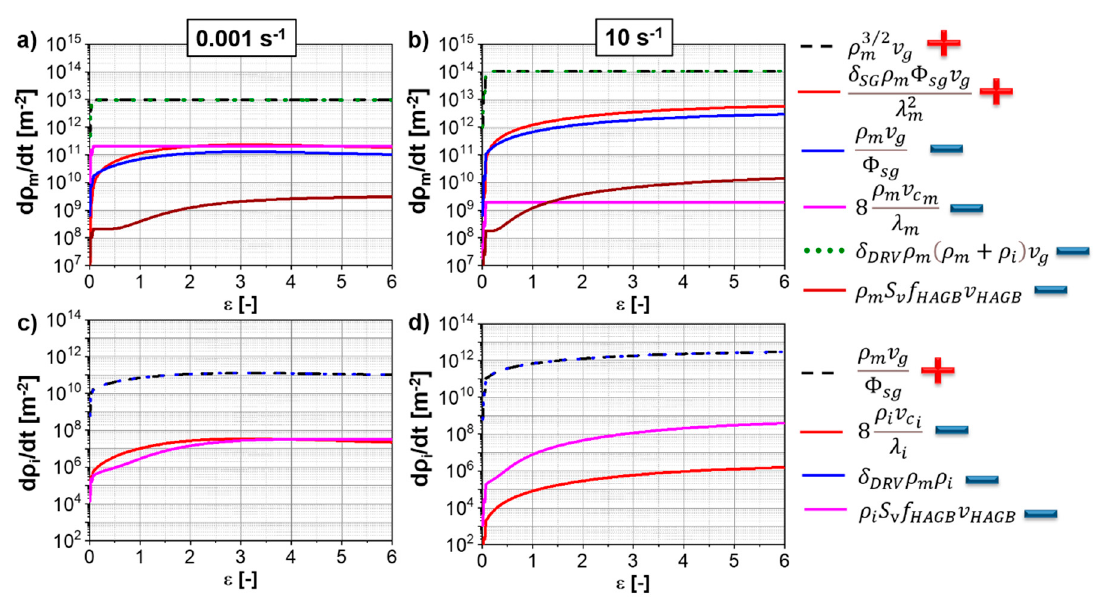
Figure 12. Evolution of the dislocation density reactions for “Model G” for the Ti-17 deformed at 970 ◦ C and ( a , c ) 0.001 s − 1 ; and ( b , d ) 10 s − 1 . ( a , b ) mobile dislocation density reactions; ( c , d ) immobile dislocation density reactions. The production terms are indicated with a “ + ” while the deduction ones with a “ − “.